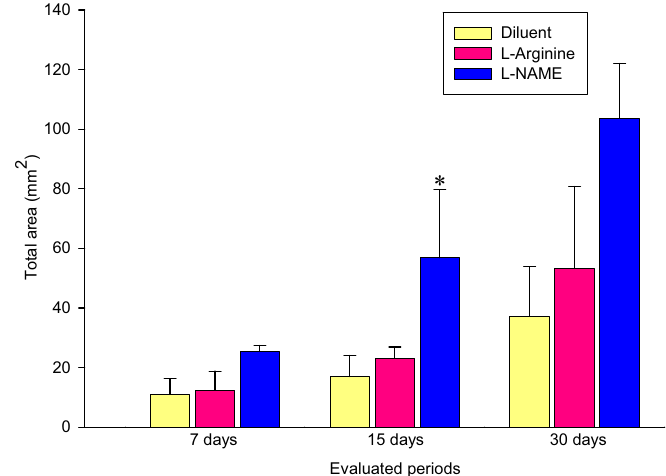
FIGURE 1 - Influence of L-Arginine and L-NAME treatments on tumor total